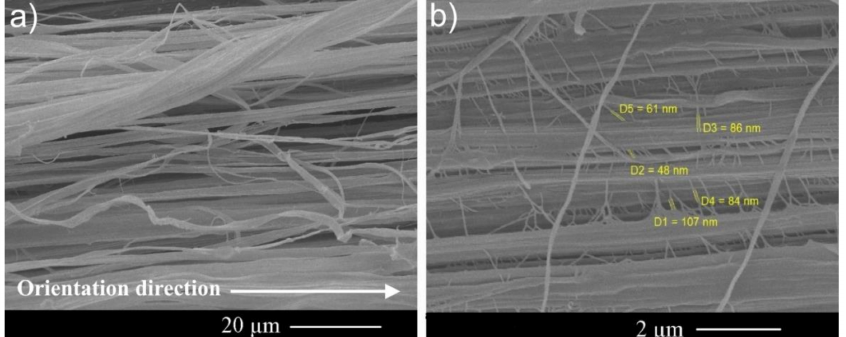
Figure 7. Typical fibrillar structure of the UHMWPE films with different magnifications. ( a ) A well-defined fibrillar structure in the UHMWPE films, ( b ) A large number of perpendicular nanofibrils to the oriented fibrils of UHMWPE with diameters in the range of 50–100